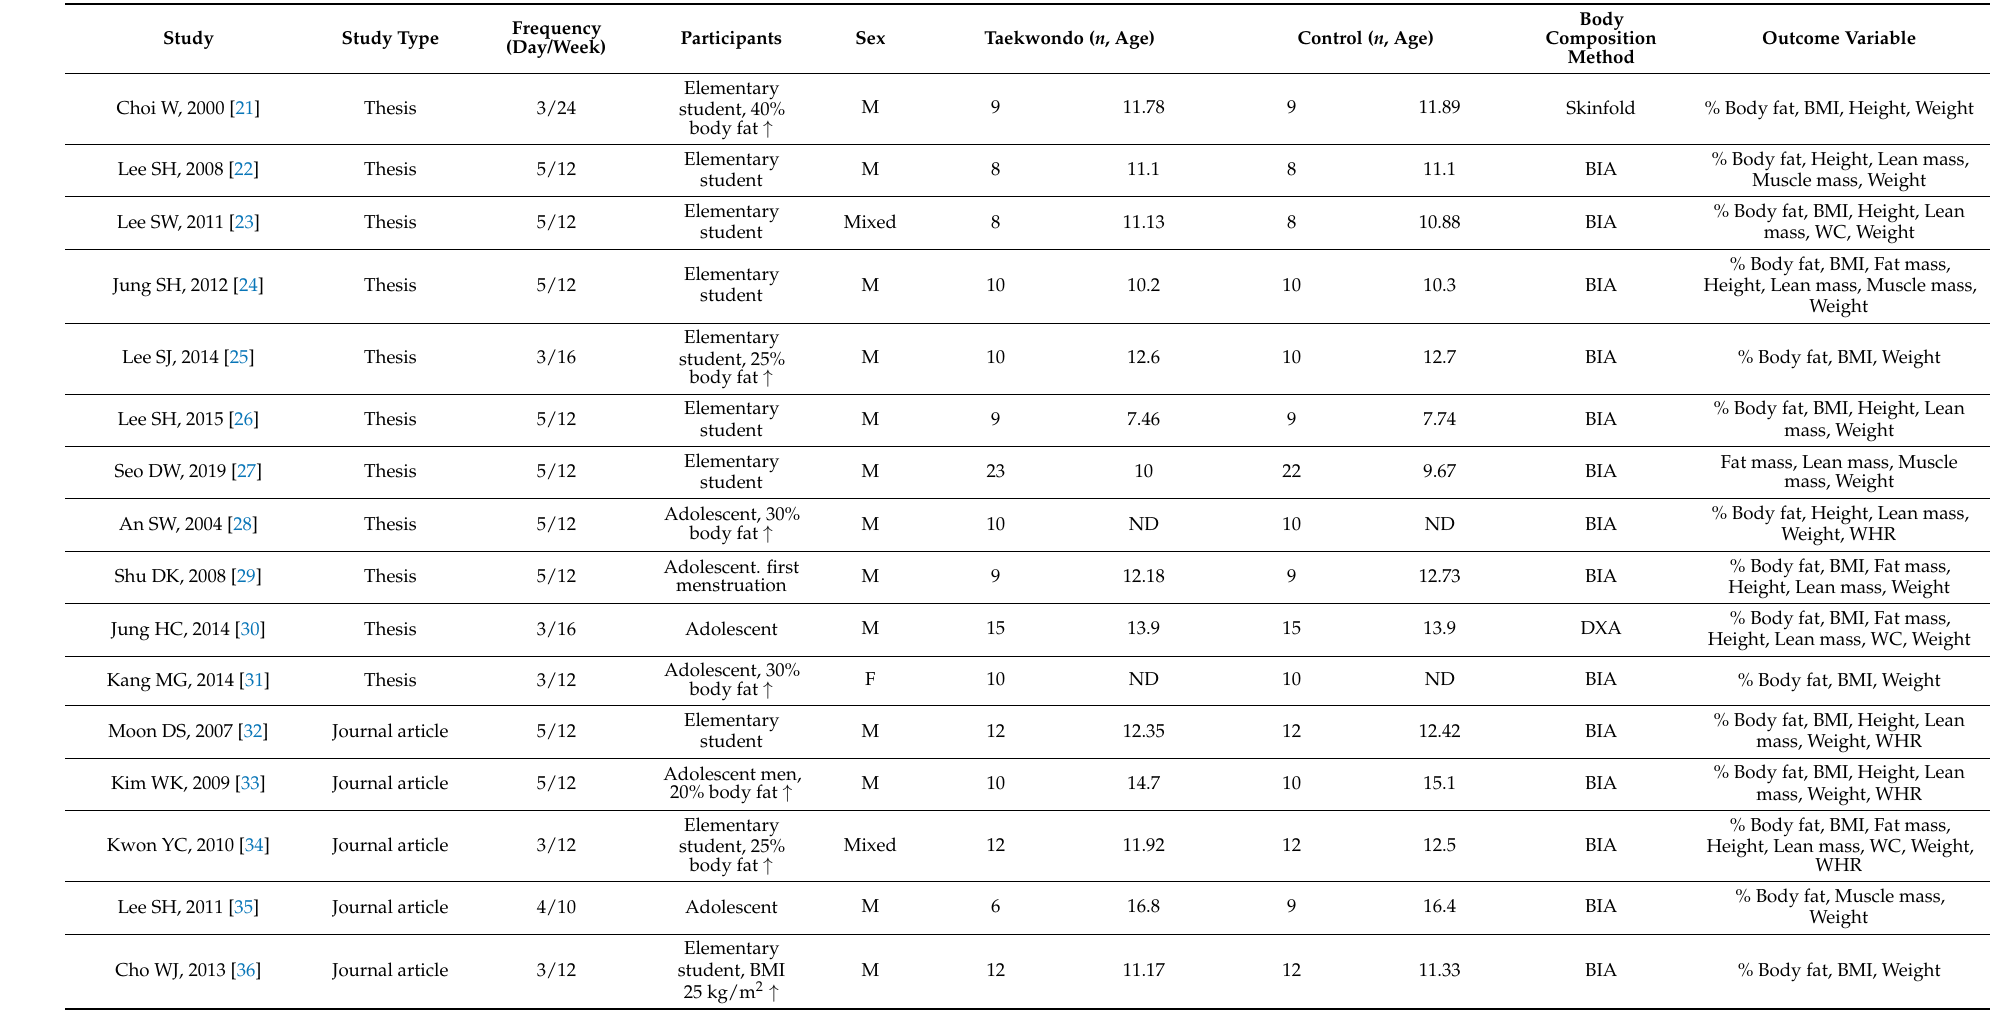
Table 1. Characteristics of included